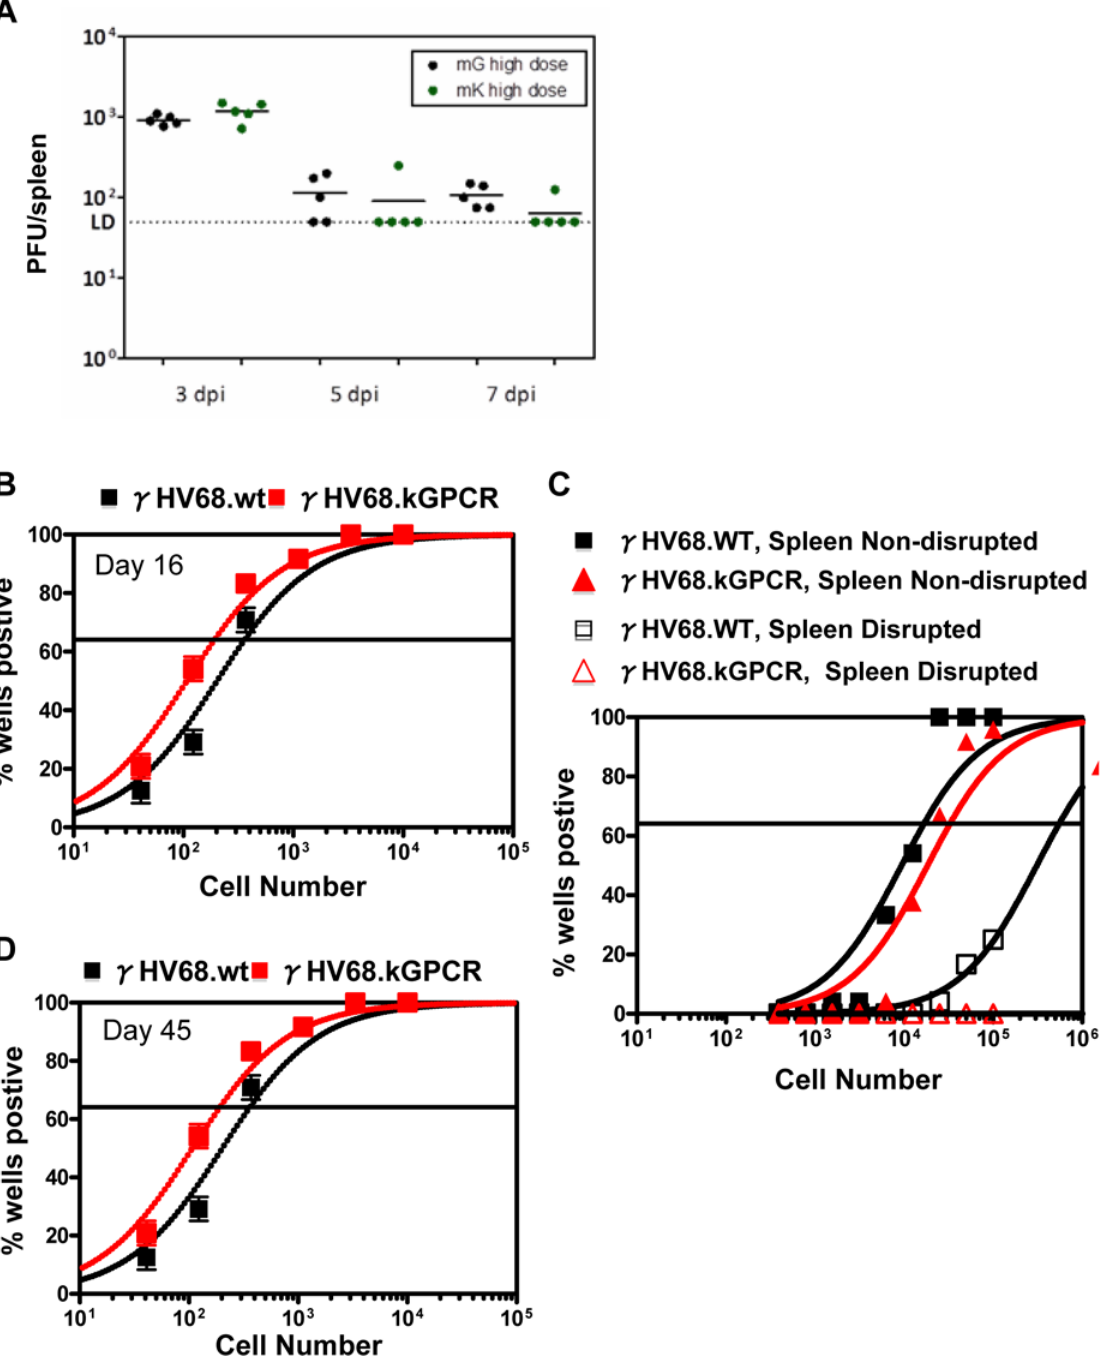
Fig 4. Acute and latent infection of γ HV68 in mouse. Balb/c mice, sex- and age-matched, were infected with wild-type γ HV68 (mG) or γ HV68.kGPCR (mK) (1 × 10 5 pfu) via intraperitoneal injection. Spleens were collected at 3, 5, and 7 days post-infection (dpi) and viral titer was determined by plaque assay (A). Alternatively, spleens were collected at 16 (B) and 45 dpi (D). Viral episomal genome was determined by limiting-dilution PCR analysis. (C) Splenocytes, either intact or disrupted with mechanic force, were co-cultured with mouse embryonic fibroblasts to allow plaque formation for 21 days.